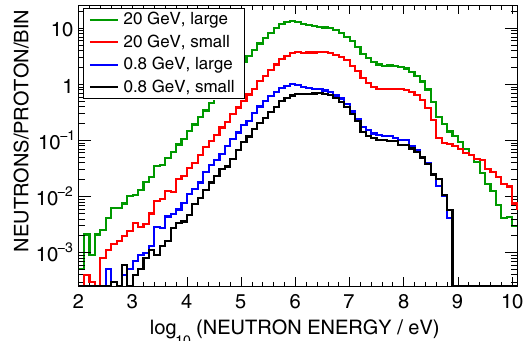
FIG. 5. Spallation neutron spectra for the different settings, see also Table I. The x-axis has a logarithmic binning with ten bins per energy decade.